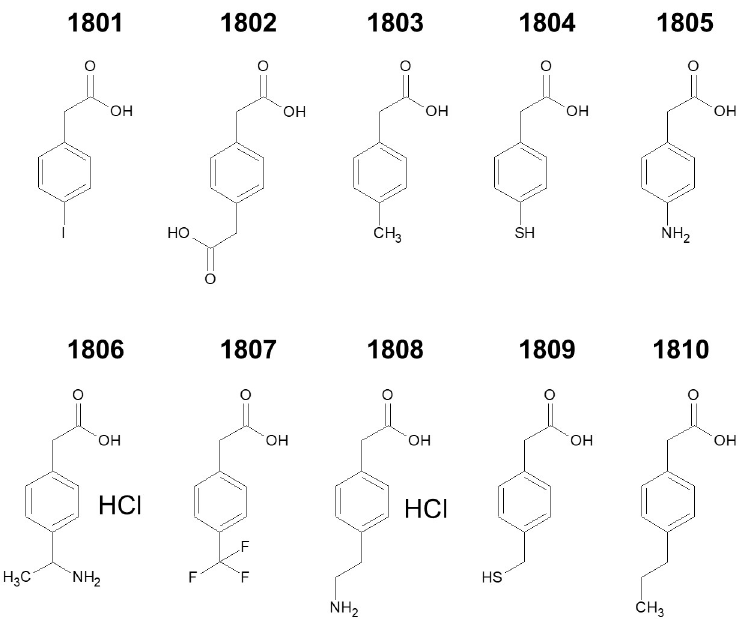
Fig 6. Substructure derivatives of 127. A total of 10 compounds containing the benzoic acid moiety were purchased and their CDK9 inhibitory activity was examined.